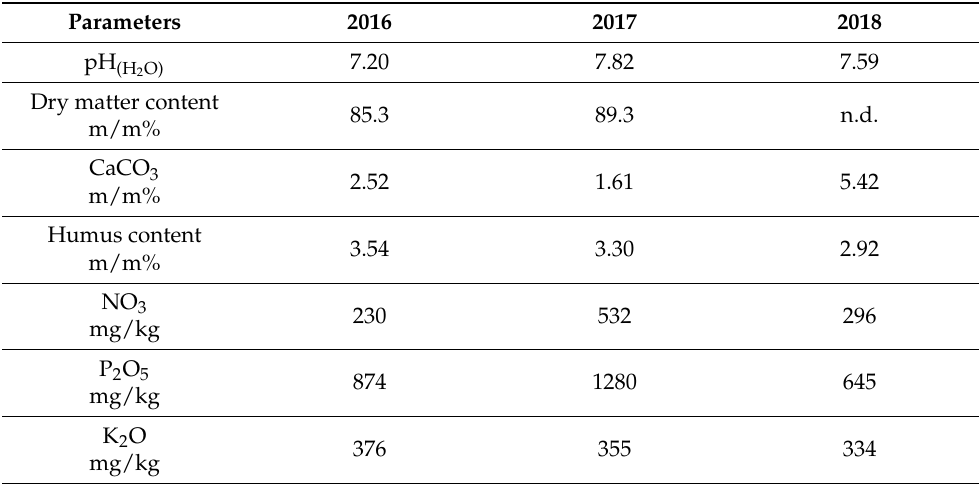
Table 1. Some soil characteristics of the experimental site in three consecutive years, at the beginning of season (sampling time: before planting, average sample of all plots).